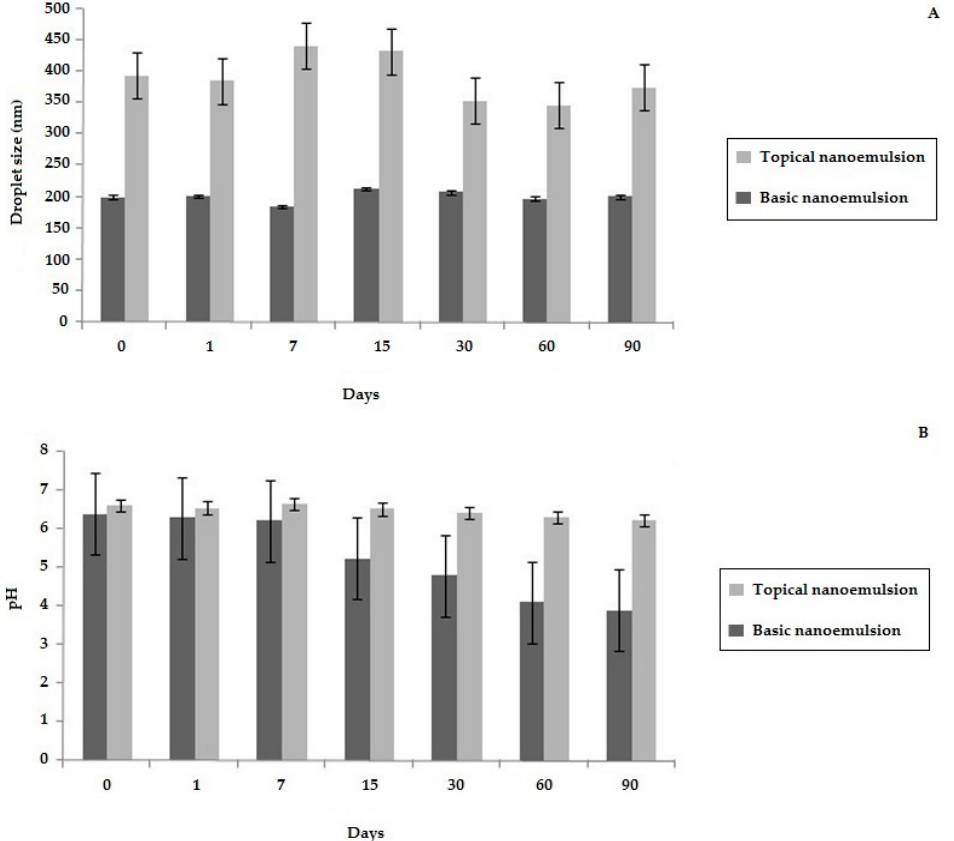
Figure 3. Droplet size and pH analyses for the basic emulsion and the topical nanoemulsion for 90 days. ( A ) droplet size analyses; ( B ) pH analyses. Dark gray: basic nanoemulsion; Light gray: topical nanoemulsion.